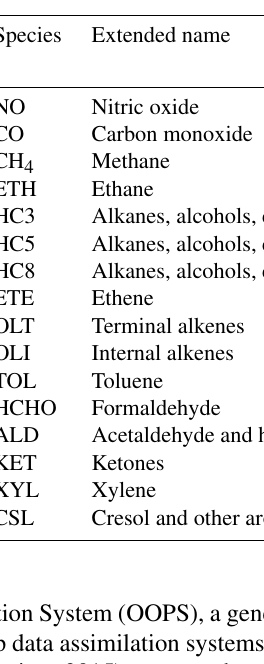
Table 3. Surface chemical emissions used for all QG-Chem experiments. Values are equal to zero for chemical species that are not listed below. Geographical scaling is further applied to these values as shown in Fig.